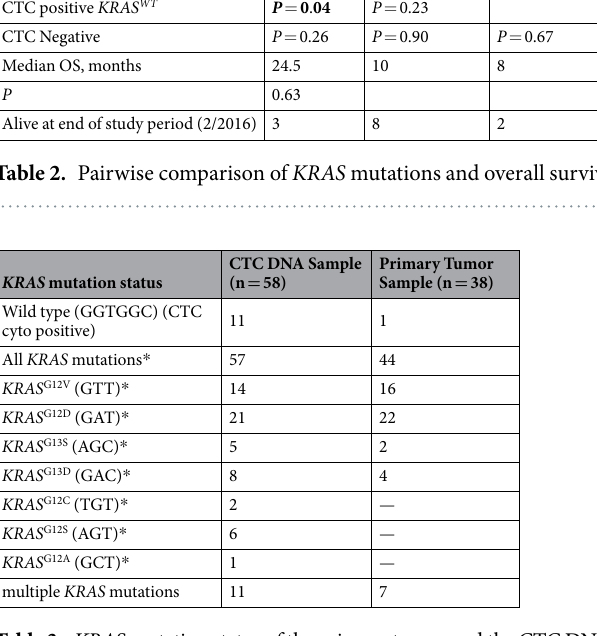
Table 3. KRAS mutation status of the primary tumor and the CTC DNA in 58 patients; in 20 cases no primary tissue was available. * Eleven patients had multiple mutations – all mutations are shown here; 6 patients with a KRAS G12D mutation had one additional mutation, and 3 patients with a KRAS G12V mutation had one additional mutation in their CTC. 4 patients had a combination of a KRAS G12V and a KRAS G12D mutation in the primary